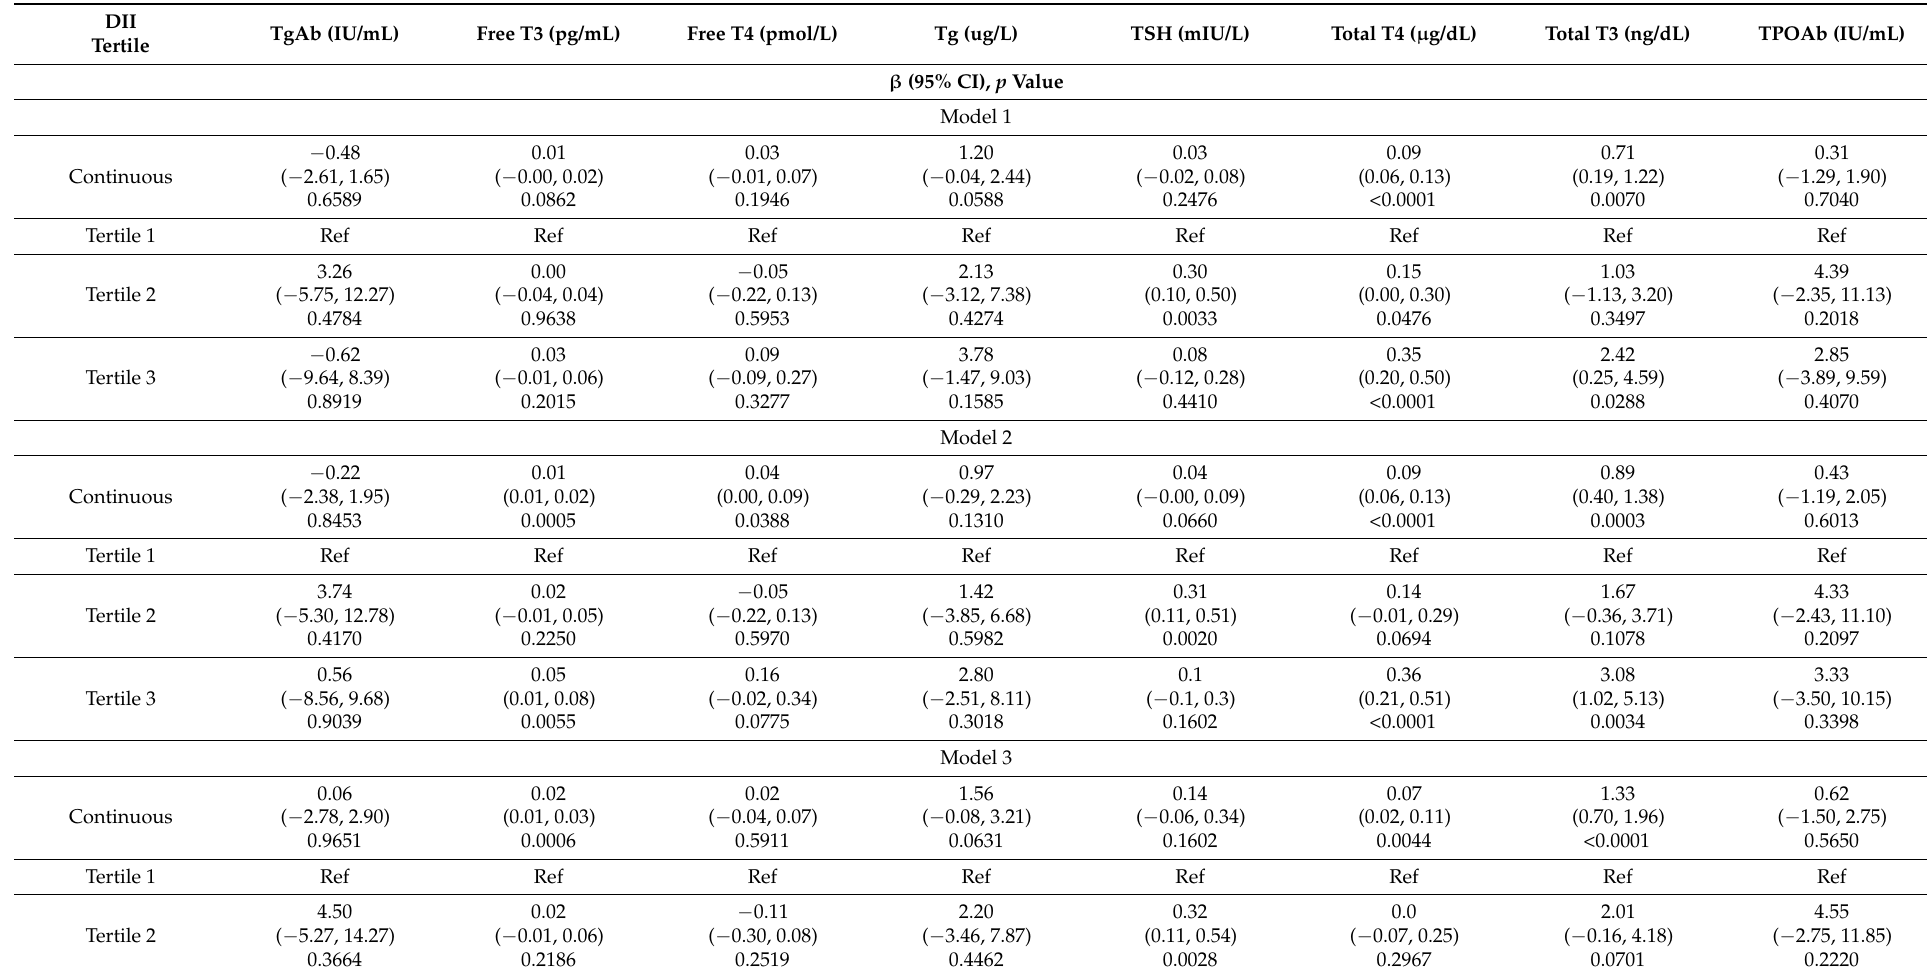
Table 2. Association between Dietary Inflammatory Index and thyroid function among U.S. adult men in NHANES from 2007 to